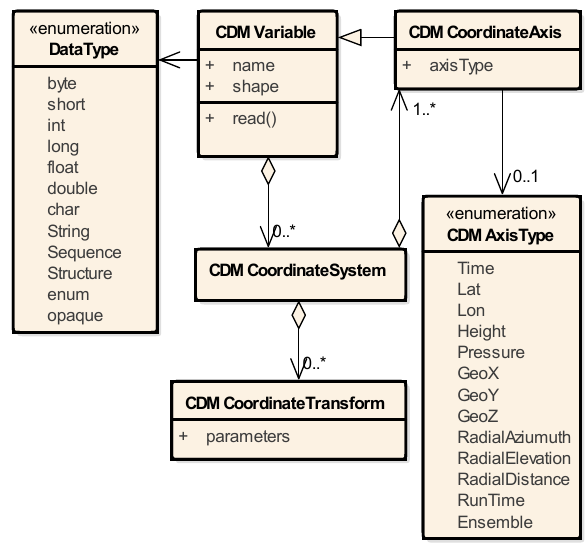
Figure 14. Key characteristics of the Unidata Common Data